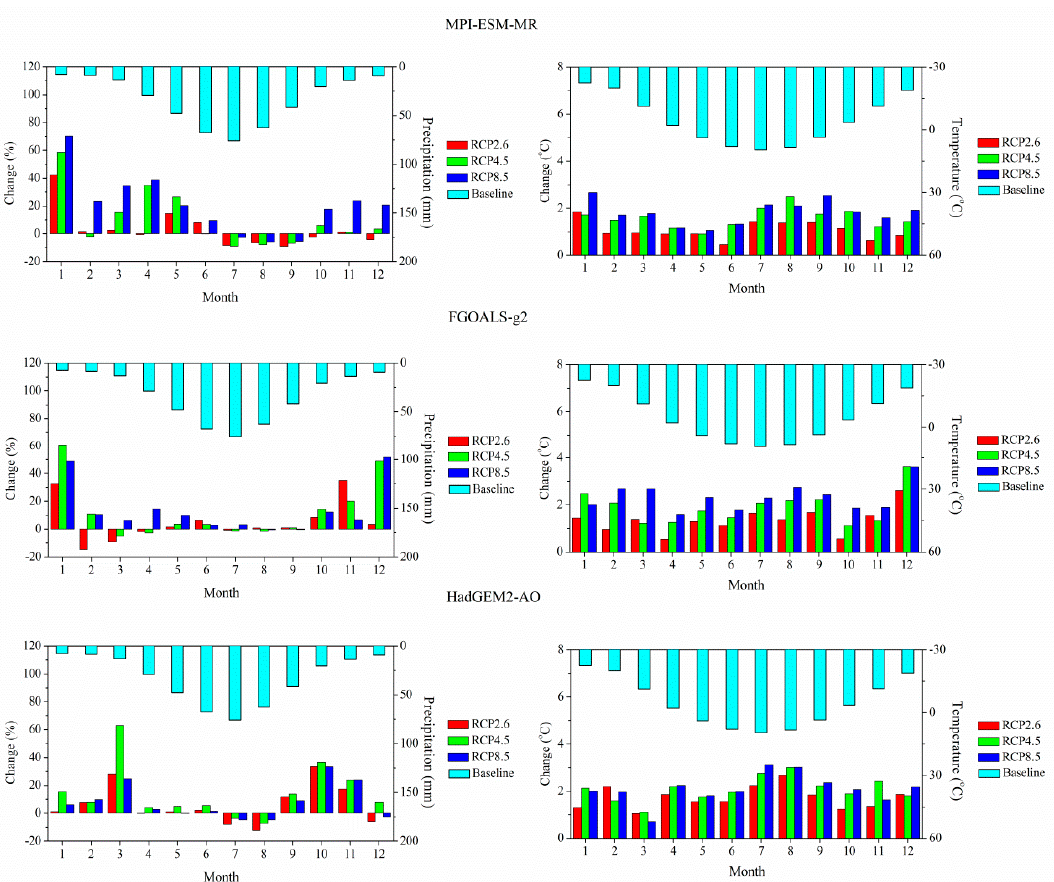
Figure 8. Monthly mean precipitation and temperature changes in the future during the period from 2021 to 2060.